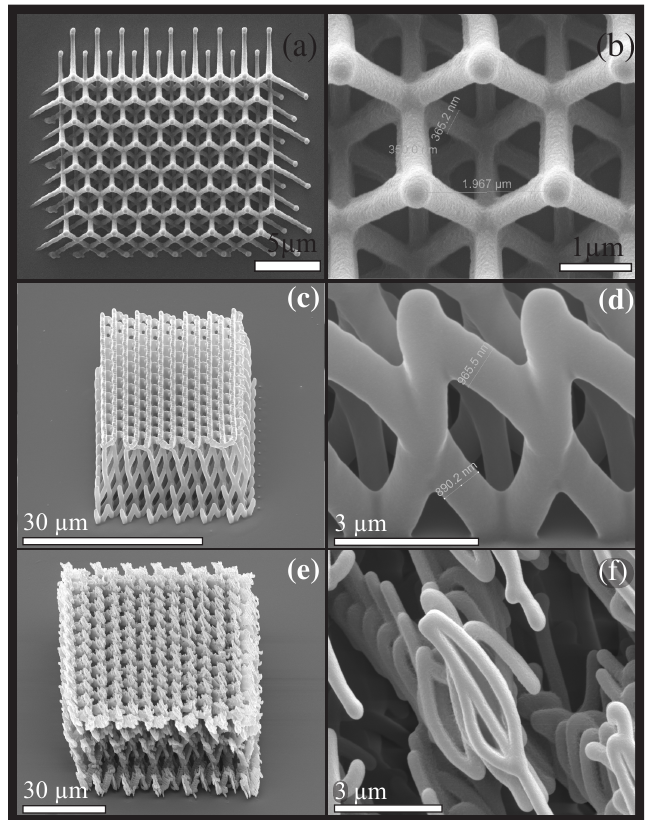
Figure 3. Scanning electron microscope images at two different scales of the photonic structures fabricated by the two-photon polymerization technology and exhibiting band gaps in the IR region. ( a , b ) Inverted yablonovite fabricated using the vector scanning